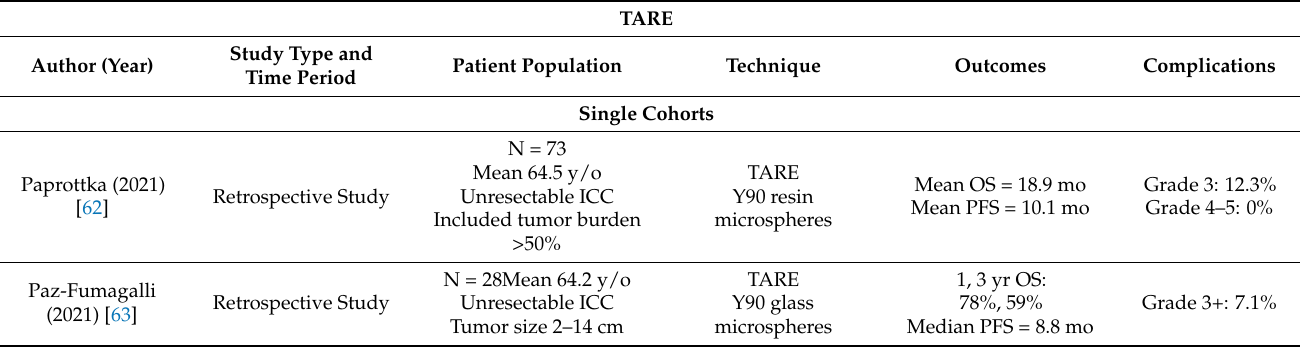
Table 4. Studies examining transarterial radioembolization (TARE) for intrahepatic cholangiocarcinoma.